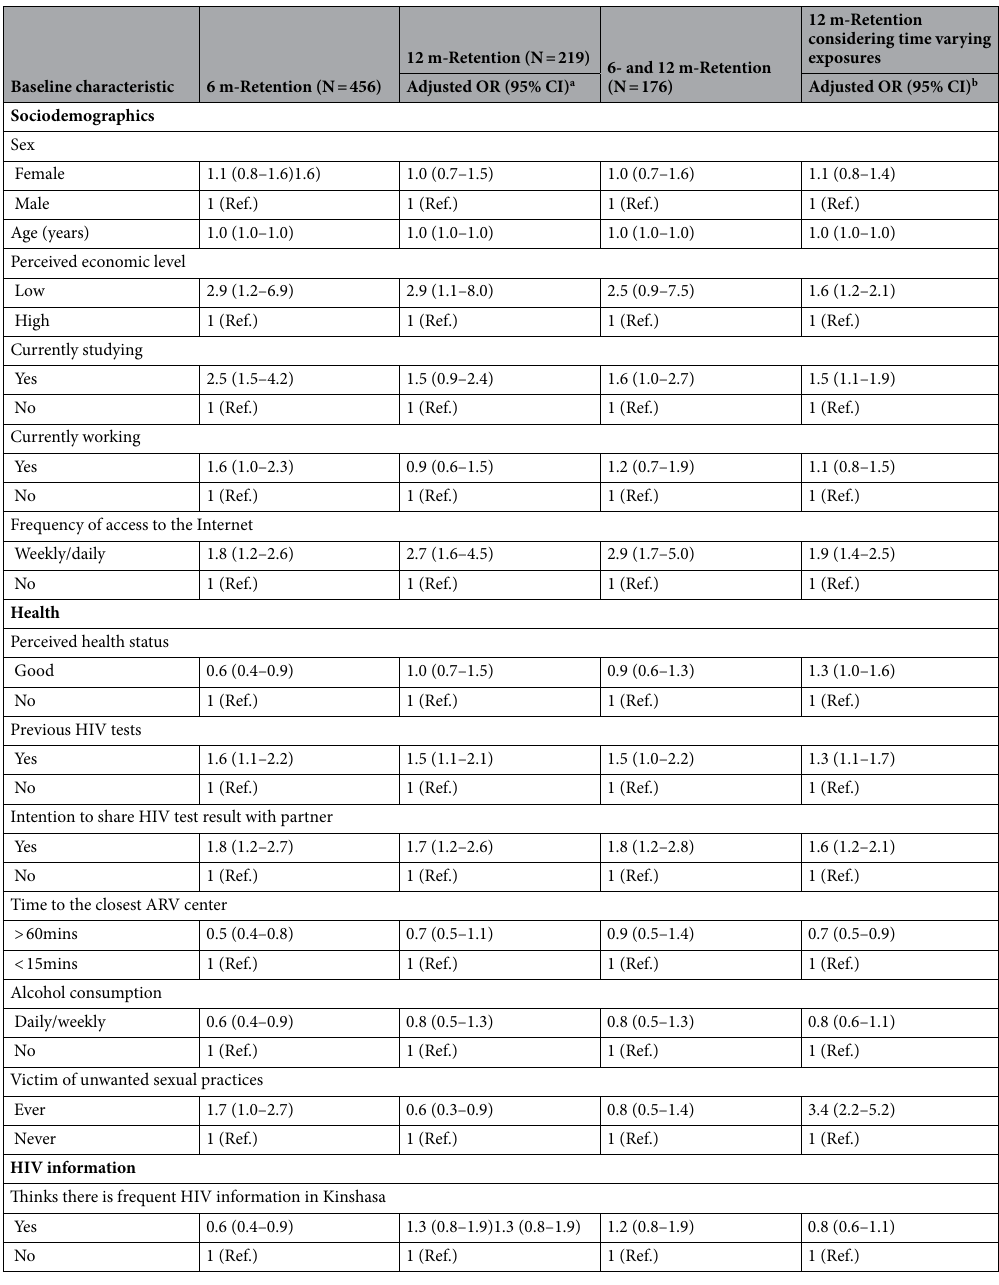
Table 2. Baseline characteristics of OKAPI participants associated with retention at 6- and 12-month follow-up (logistic regression adjusted Odds Ratios). a Multivariate logistic regression including all variables in the table and the corresponding Odds Ratios and their 95% confidence intervals. b Multivariate logistic regression including all variables in the table and the corresponding Odds Ratios and their 95% confidence intervals (Generalized Estimated